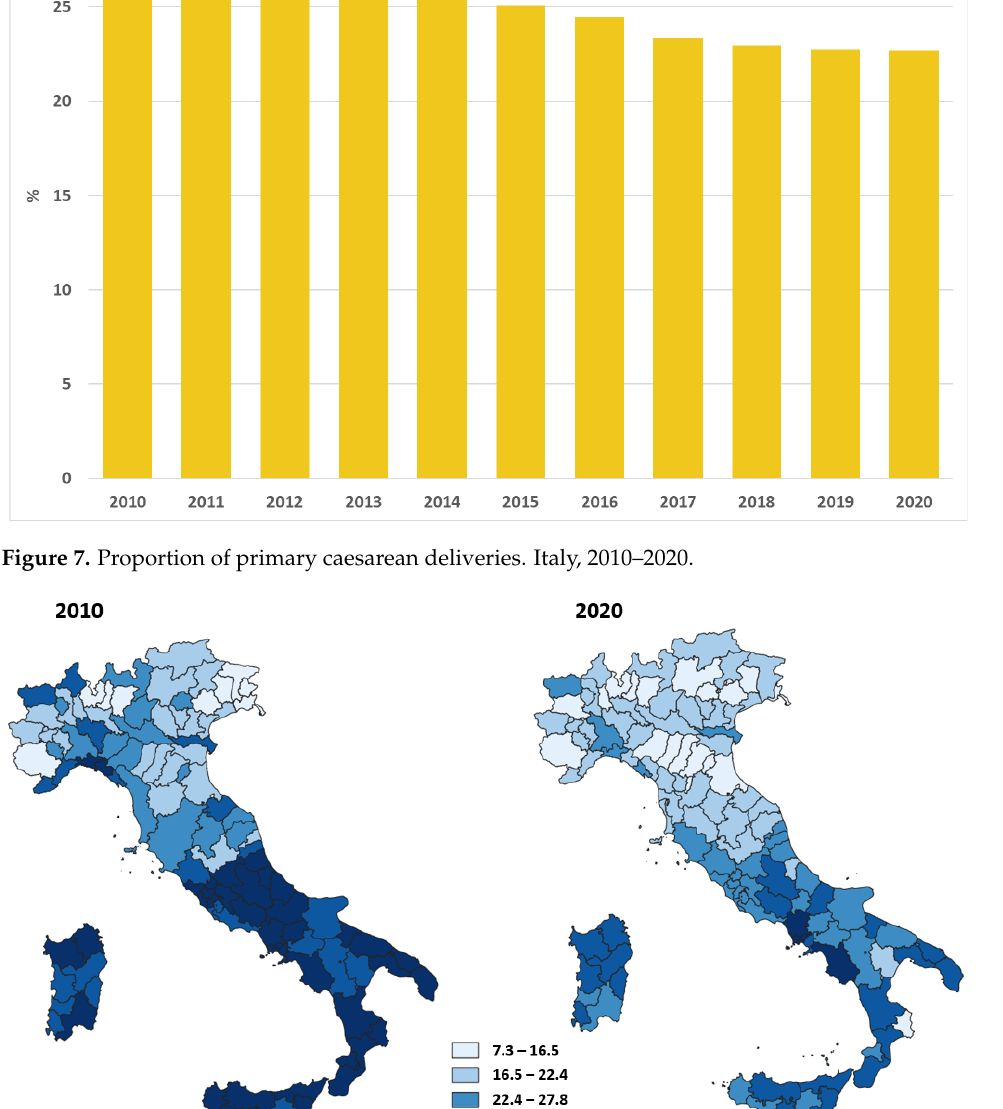
Figure 8. Adjusted proportion of primary caesarean deliveries for Italian area of residence in 2010 and 2020.